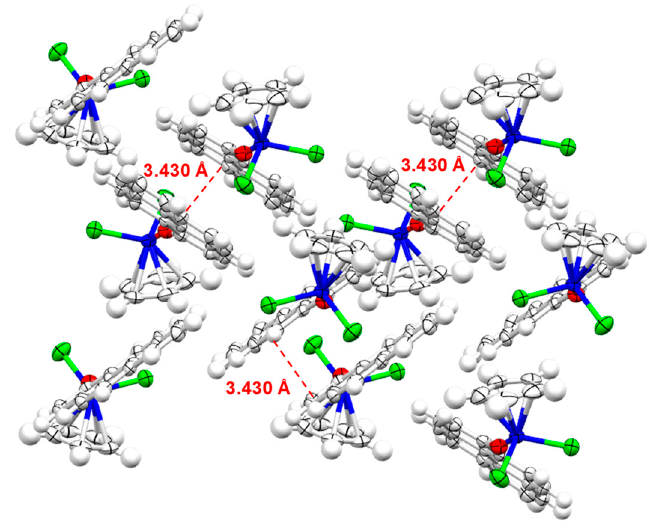
Figure 4. Single crystal packing diagram of complex Ti3 .